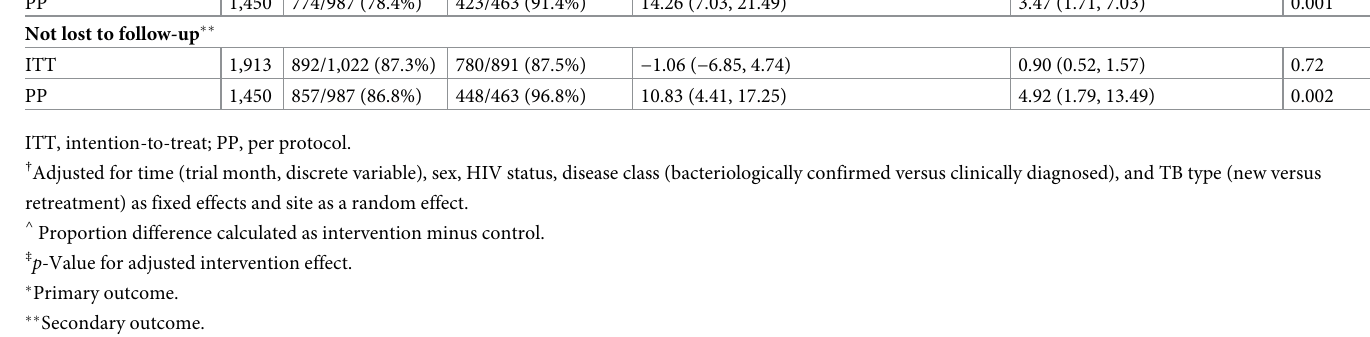
In subgroup analyses, the effect of the 99DOTS-based intervention was strongest in men and HIV-positive patients. Within the ITT study population, the odds of treatment success were increased among men (aOR 1.24, 95% CI 0.73, 2.10) and HIV-infected patients (aOR 1.51, 95% CI 0.81, 2.85), but the aORs and the between-group differences for men and women